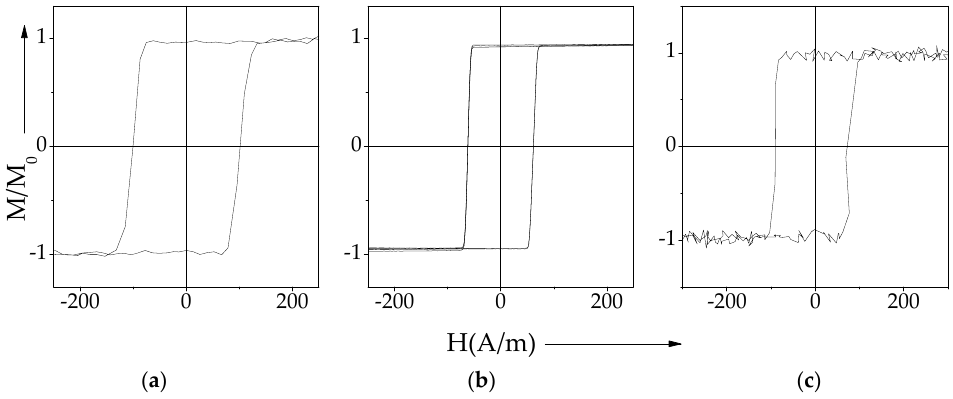
Figure 11. Hysteresis loops of as-prepared Fe 77.5 Si 7.5 B 15 ( a ), Fe 47.4 Ni 26.6 Si 11 B 13 C 2 ( b ), and Fe 16 Co 60 Si 13 B 11 ( c ) microwires. Reprinted with permission from [60]. Copyright © 2021 MDPI Publishing, Open Access.